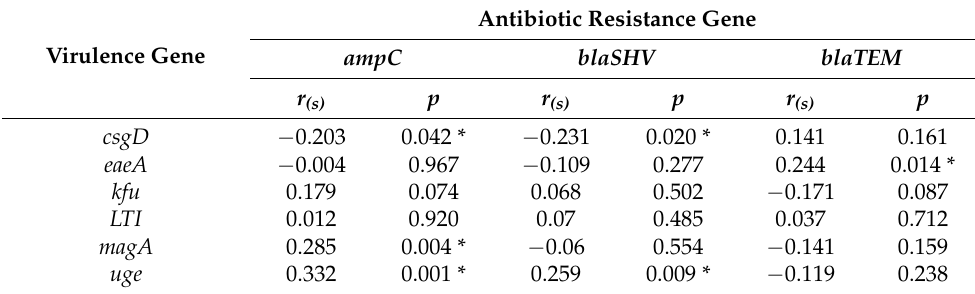
Table 6. Nonparametric correlation analysis of antibiotic resistance genes and virulence genes.